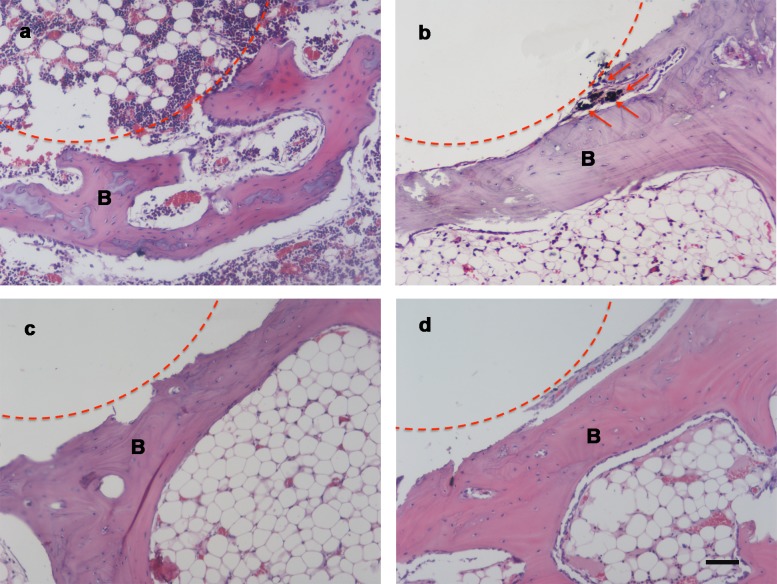
Histology of medial femoral condyle 12 weeks after implantation of blank, mcm, PCM and CCM (H&E staining), showing bone tissue growth.Scale bars: 100 μm. (a) The dotted line represents the punching site. (b-d) The dotted line represents the implant materials. B = bone.